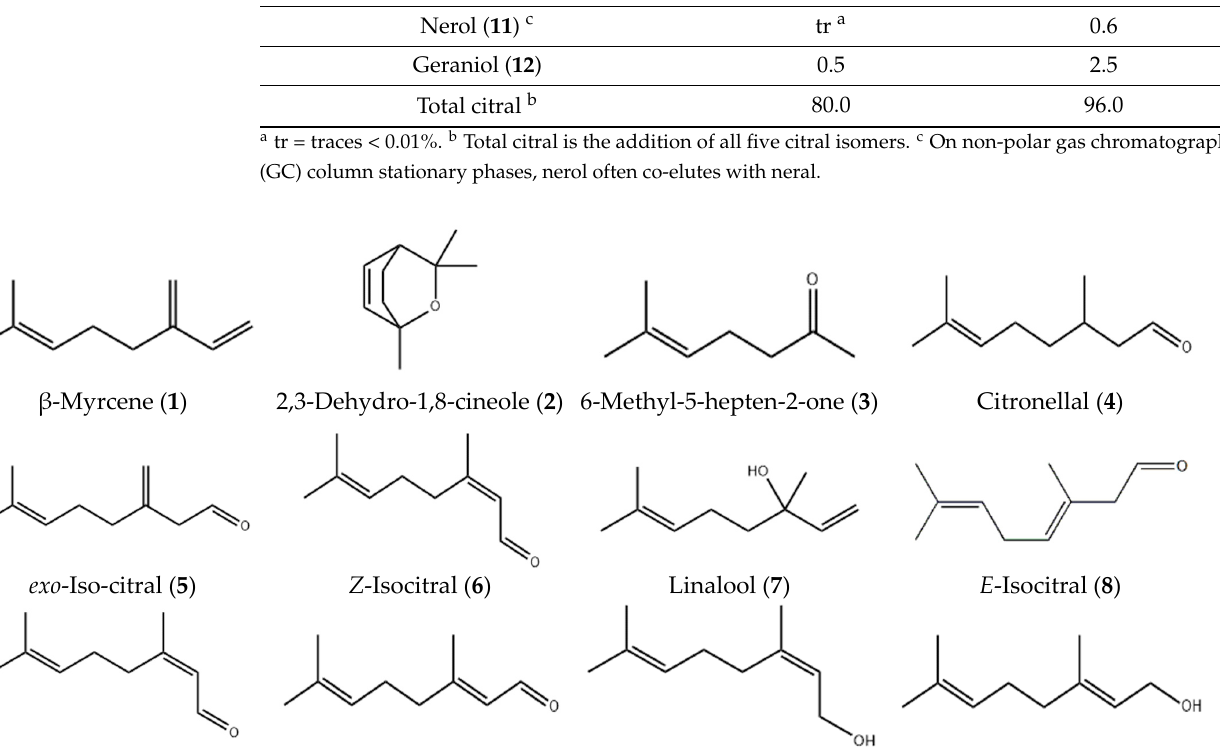
Figure 3. Gas chromatographic trace of B. citriodora oil on a polar column.